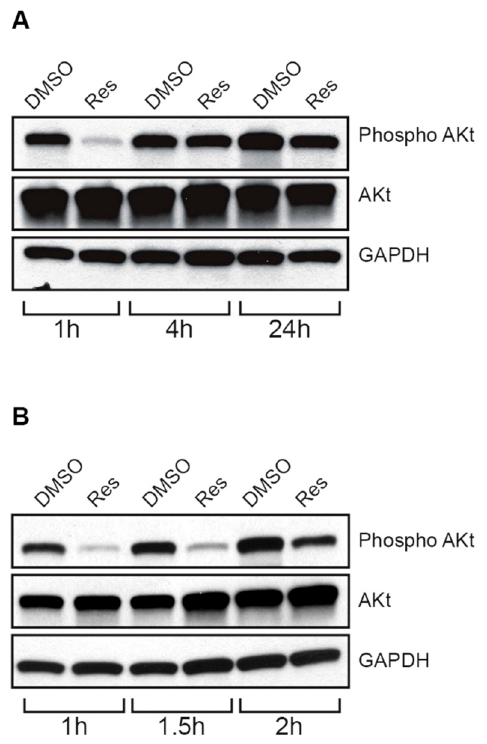
Figure 9. Resveratrol inactivates Akt/protein kinase B in choroidal endothelial